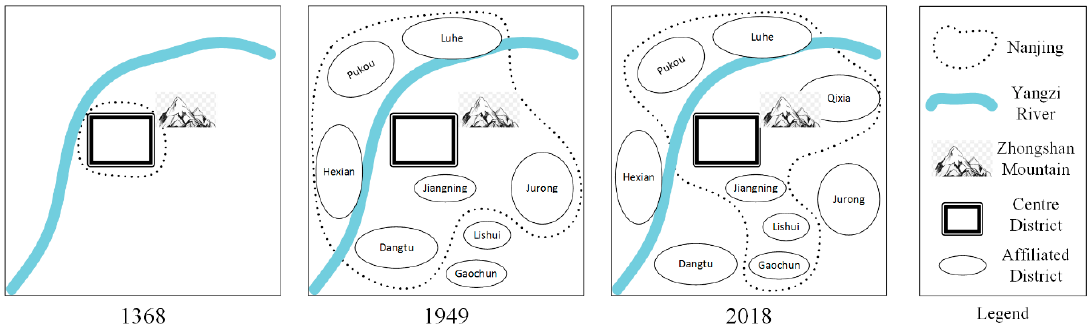
Figure 4. The sketch maps of administrative divisions evolution of Nanjing in 1368, 1949, and 2018.